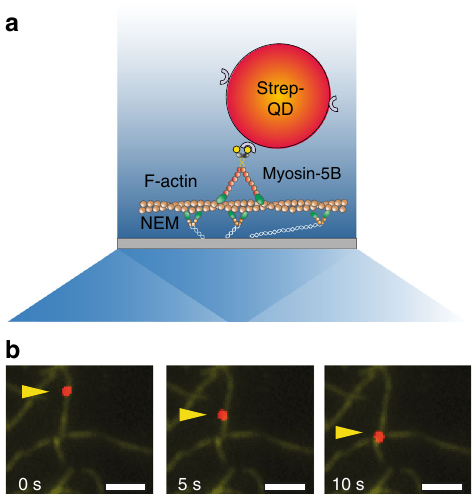
Fig. 1 Processive movement of myosin-5B on F-actin in the single-molecule in vitro motility assay. a Schematic of the myosin-5B single